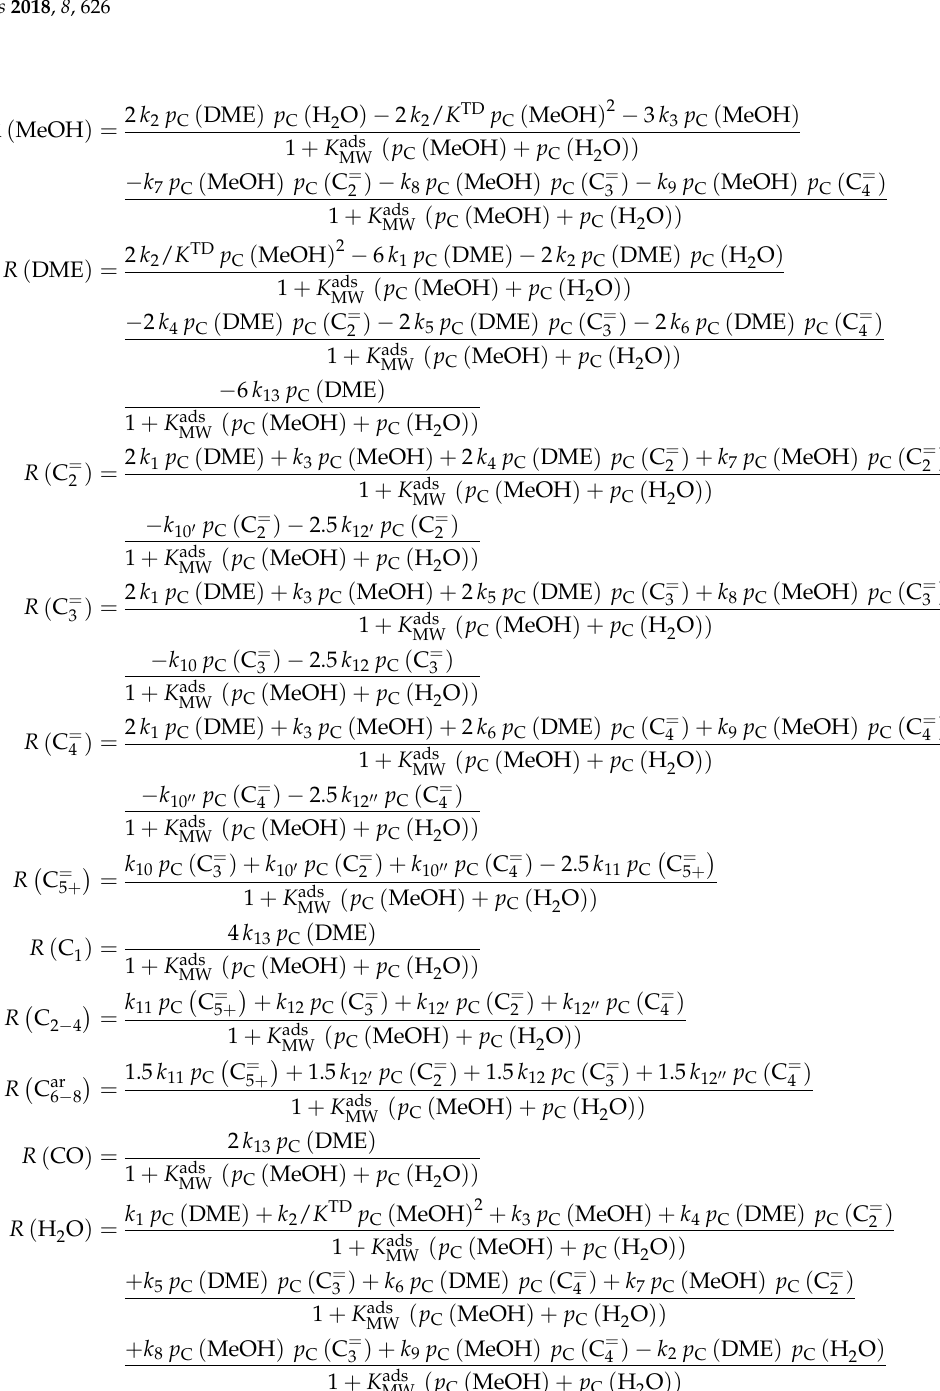
Scheme 26. Net rates of production of the different lumps for the model by Pérez-Uriarte et al.